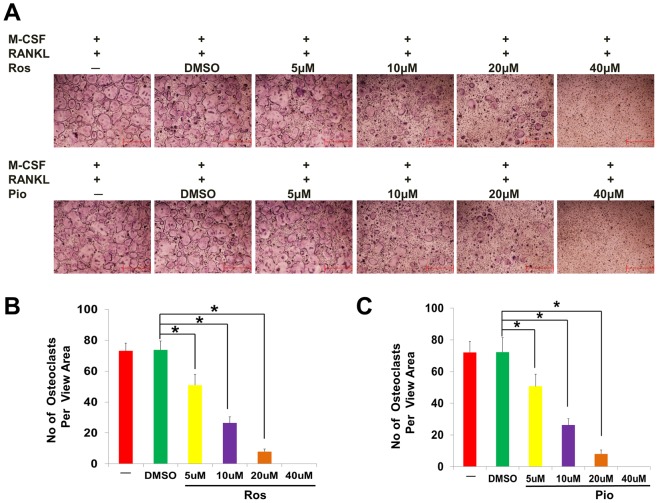
Rosiglitazone and pioglitazone inhibit RANKL-mediated osteoclastogenesis in tissue culture plates.(A) BMMs were treated with M-CSF (44 ng/ml) and RANKL (100 ng/ml), or M-CSF (44 ng/ml) and RANKL (100 ng/ml) plus vehicle (DMSO) or different doses (5 µM, 10 µM, 20 µM or 40 µM) of rosiglitazone (Ros) or pioglitazone (Pio) for 4 days. The cultures were then stained for TRAP activity. All assays were performed in triplicate and repeated 3 times. One representative view from each condition is shown. (B) Quantification of osteoclastogenesis assays for Ros in A. (C) Quantification of osteoclastogenesis assays for Pio in A. The number of multinucleated TRAP-positive cells (>3nuclei) per representative view area at 40× magnification was obtained. Bars show averages of three replicates ±S.D. *P<0.05.